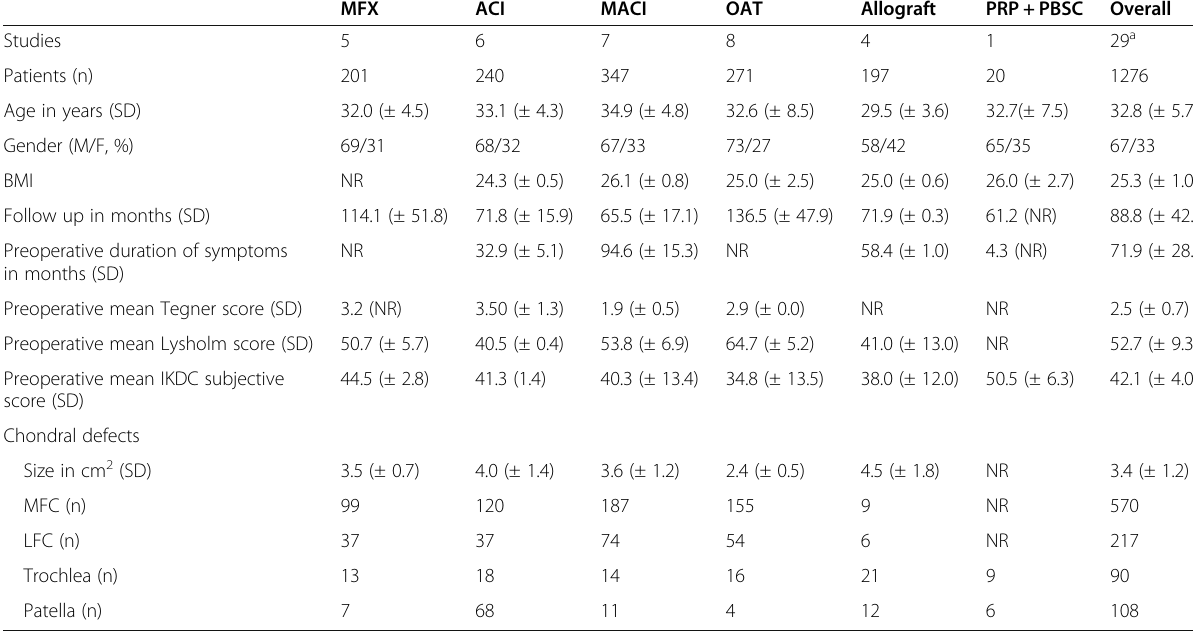
Table 2 Patient demographics from the included